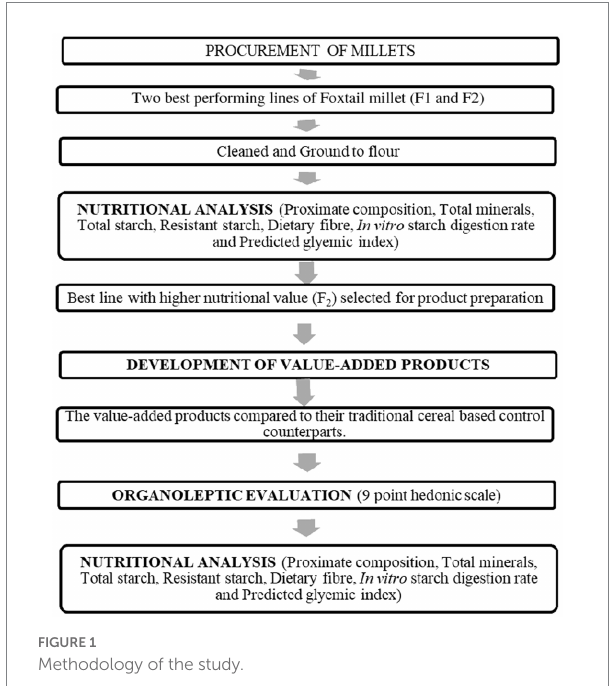
FIGURE 1 Methodology of the